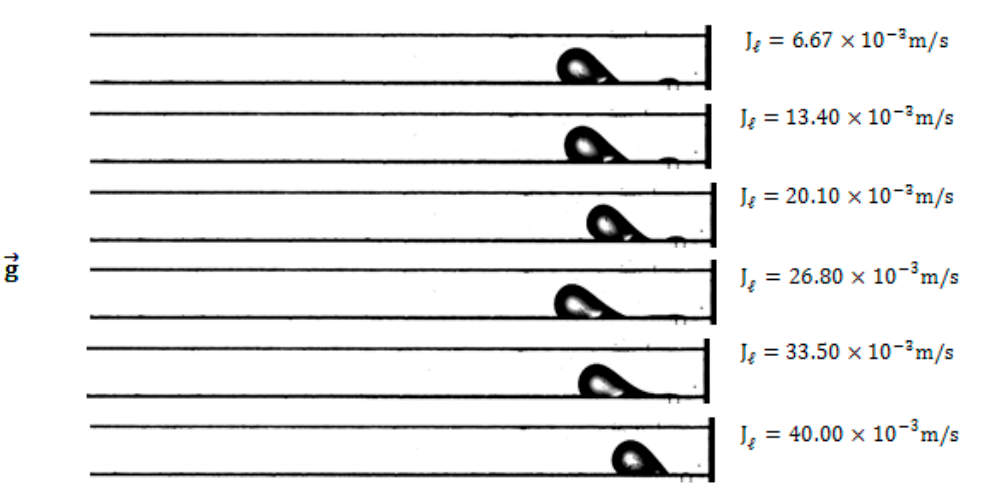
Figure 11. Slug formation.